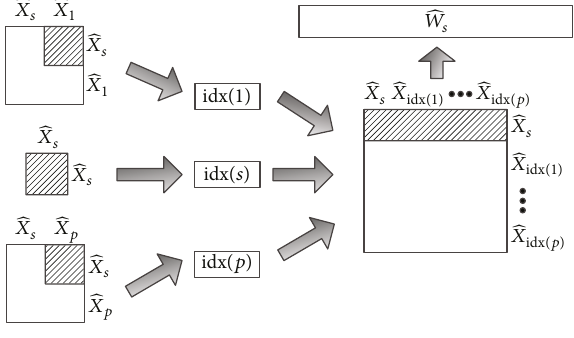
Figure 3: Manifold construction in